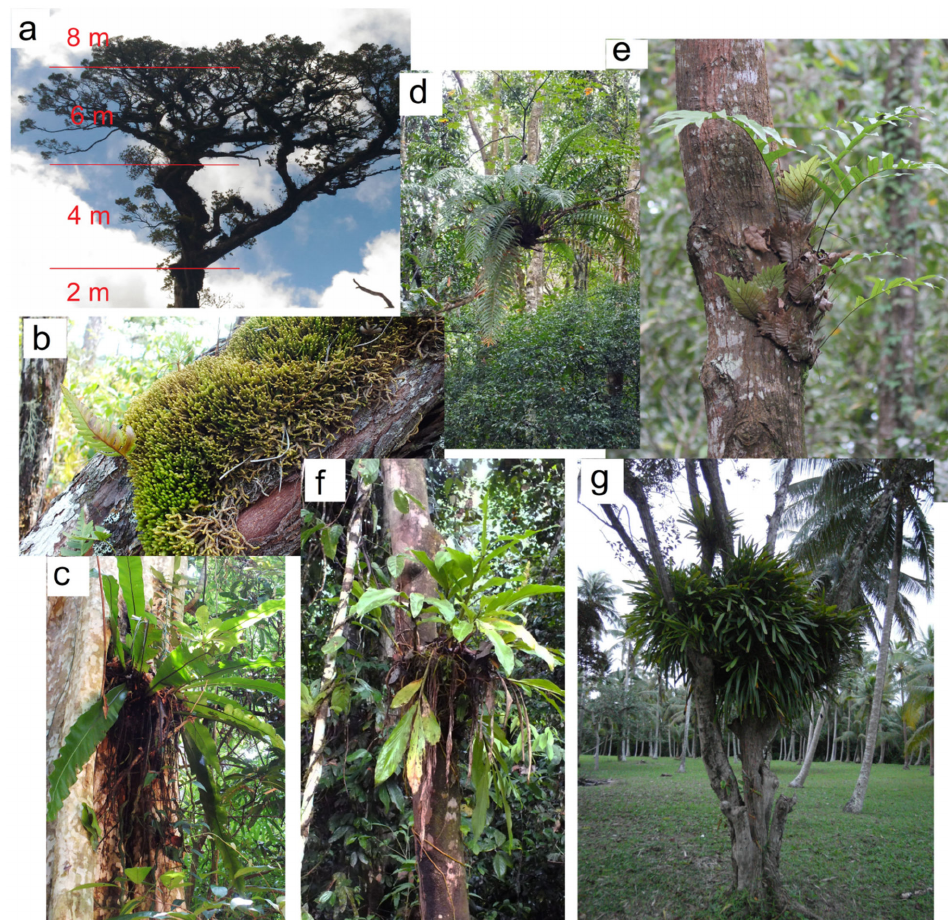
Figure 2. Some epiphytic communities and epiphytes from which suspended soils were collected: ( a ) Lyonia ovalifolia tree in np Bidup Nui Ba from which suspended soils were collected from heights up to 2 m, mainly under mosses and ferns; 2–4 m. moss cushions with ferns and small orchids underplanted; 4–6 m, mainly large orchids and heather and 6–8 m, mainly small orchids and lichens on individual thin branches; ( b ) moss cushions with suspended soils form in the mountain forest of np Bidup Nui Ba; ( c ) classical nesting epiphyte Asplenium nidus forms suspended soils in a lowland forest (Cat Tien park); ( d ) staple epiphyte Aglaomorpha sp. in mountain forest of Bidup Nui Ba; ( e ) staple epiphyte Drynaria quercifolia in lowland forest (Cat Tien park); ( f ) nesting epiphyte Hedychium bousigonianum in lowland forest (Cat Tien) and ( g ) nesting epiphyte Cymbidium finlaysonianum in a sparse community (Phu